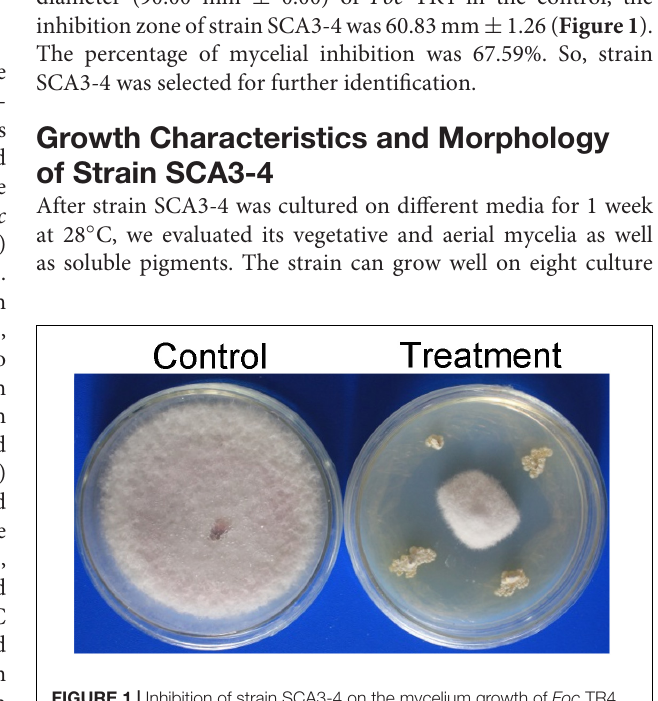
FIGURE 1 | Inhibition of strain SCA3-4 on the mycelium growth of Foc TR4. Control, plate inoculated only with Foc TR4; Treatment, plate inoculated with Foc TR4 and strain